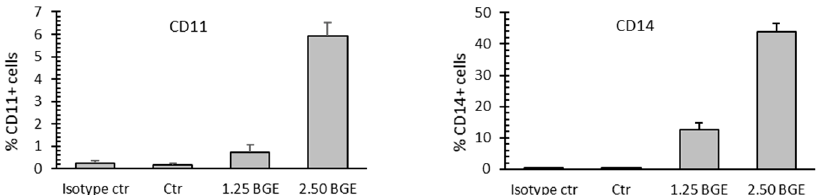
Figure 6. Black garlic methanol extract (BGE) induced hematological cancer cell differentiation. FACS analysis of CD11c (left) and CD14 (right) expression in U937 cells upon treatment with 1.25 and 2.50 mg/mL BGE for 24 h, as compared to untreated cells (Ctr). Error bars: standard deviation from independent experiments in duplicate. Isotype control (ctr) as negative